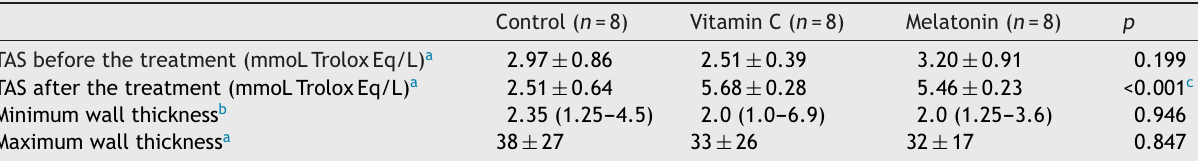
Table 1 Total antioxidant status and wall thickness in the study